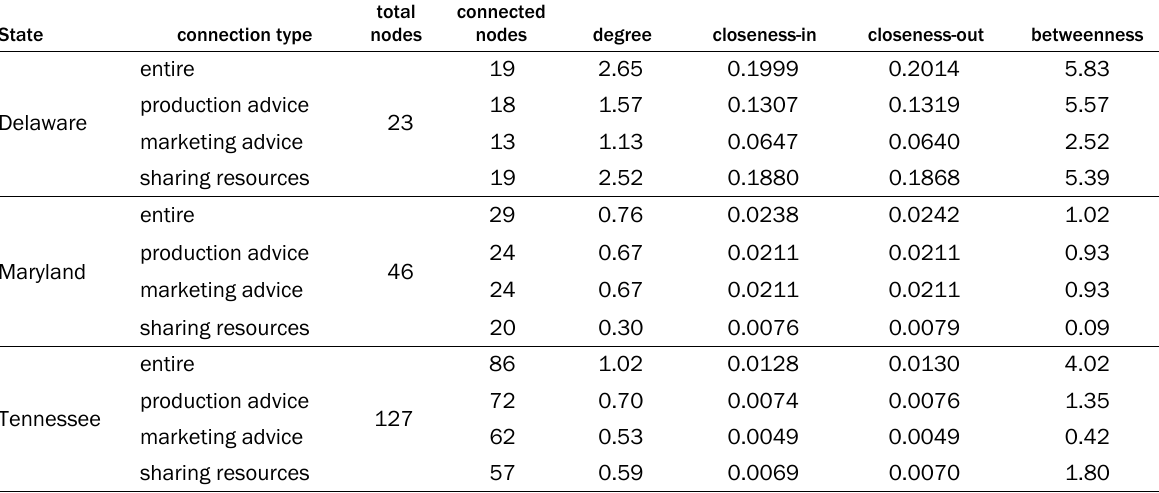
Table 2. Summary of Network Connection Types and Network Centrality Among Small Farmers